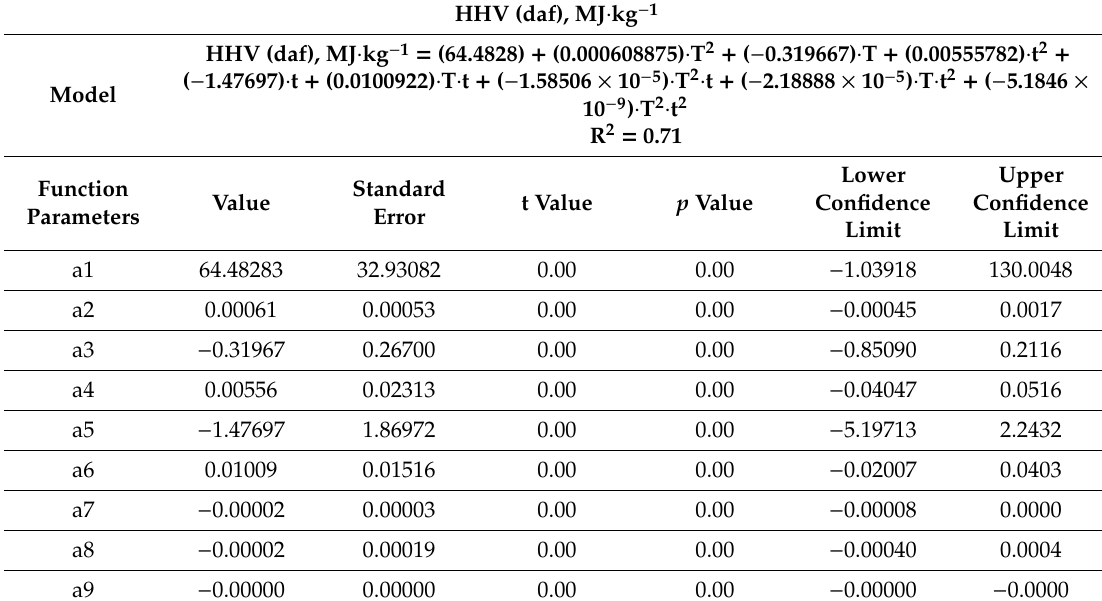
Table A9. The statistical parameters of polynomial regression analysis of the influence of SS torrefaction temperature and residence time on HHV daf of the